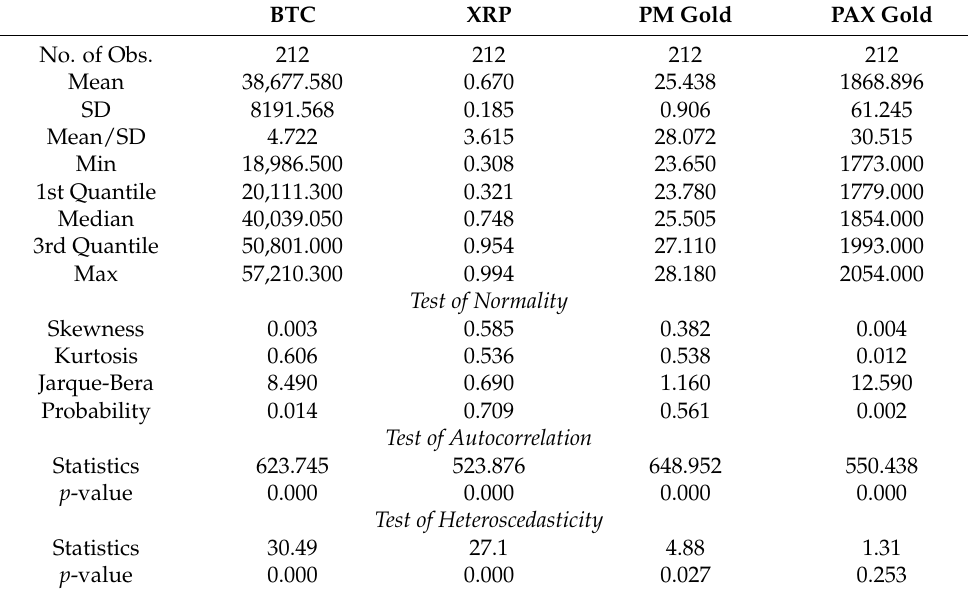
Table 1. Descriptive